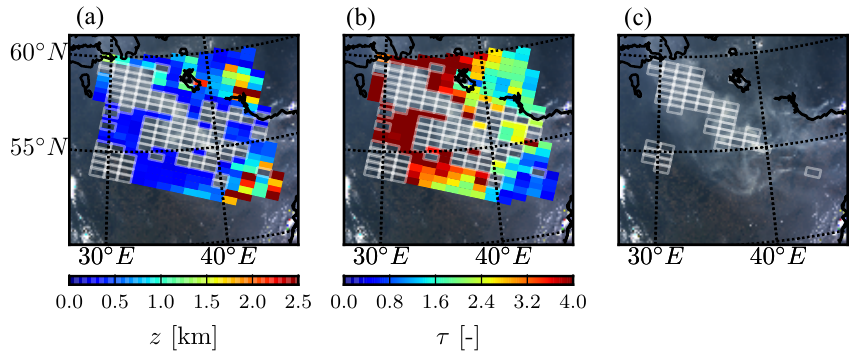
Figure 8. (a) Retrieved aerosol layer height from GOME-2A measurements of the 2010 Russian wildfires, in kilometres above the ground with the aerosol layer height retrieval algorithm. Empty white boxes represent pixels that do not converge to a solution. (b) Retrieved aerosol optical thickness from the same retrievals. (c) GOME-2A pixels for which there exist possible aerosol–surface ambiguities (empty pixels with white borders).